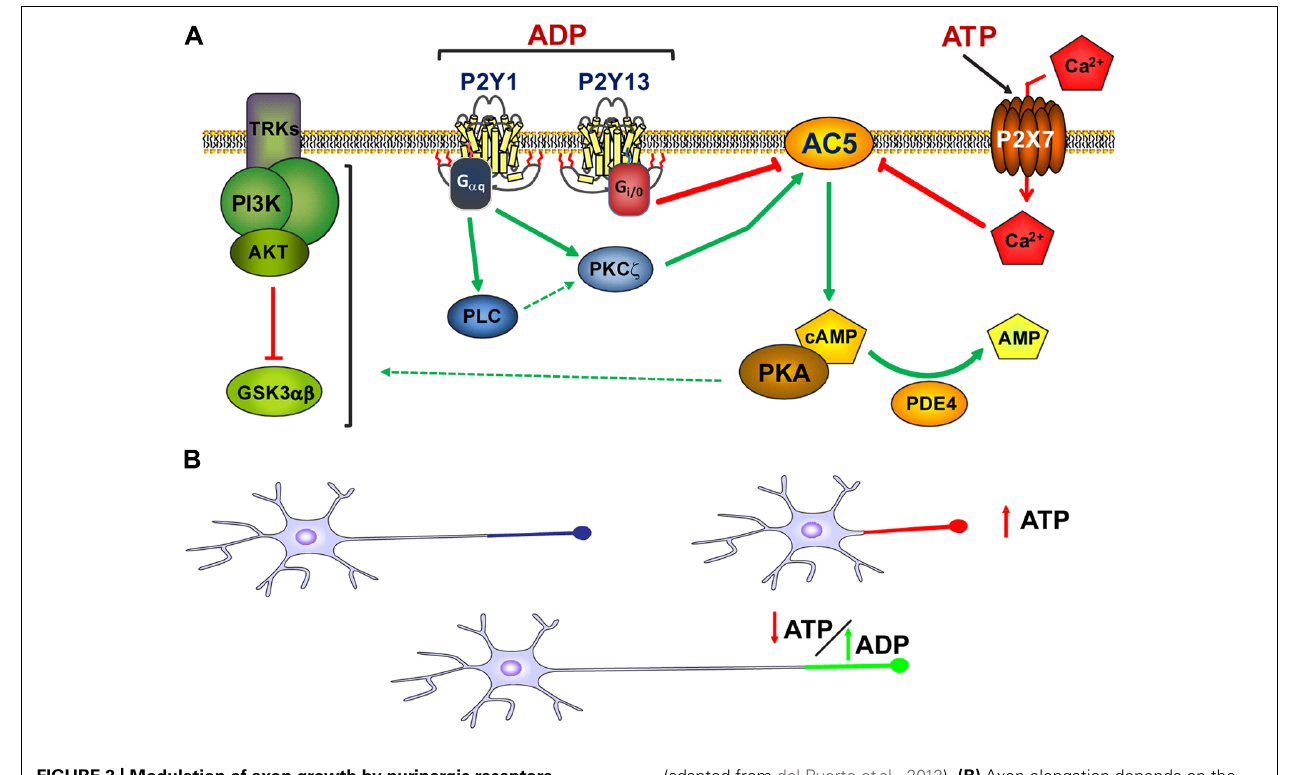
(adapted from del Puerto etal., 2012). (B) Axon elongation depends on the extracellular concentration of ATP. High extracellular concentrations of ATP provoked by cell damage, programed apoptosis, or other physiological and/or pathological conditions diminish axon elongation. However, in the absence of high extracellular concentrations of ATP, ADP can trigger P2Y1 receptors and promote axon elongation.The balance between the extracellular concentrations of purines and the activity of purinergic receptors modulates axonal